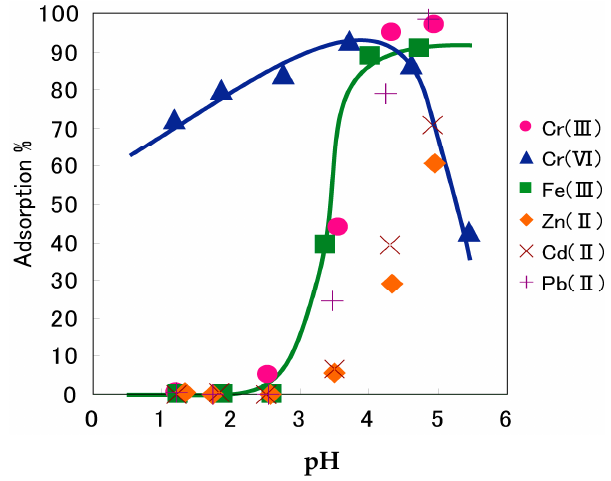
Figure 35. Adsorption of some metal ions from a HEPES buffer solution by crosslinked grape gel at different equilibrium pH values [36]. (With permission for reuse from Elsevier B.V.).